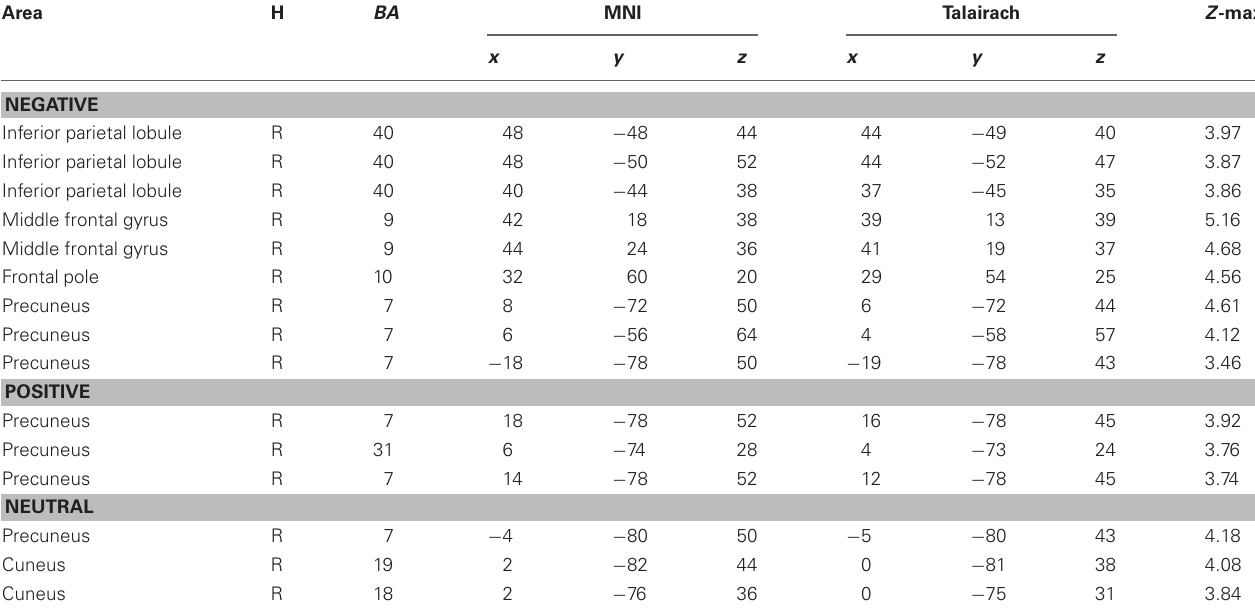
Table 3 | Brain regions showing negative connectivity with the left amygdala across groups. Area